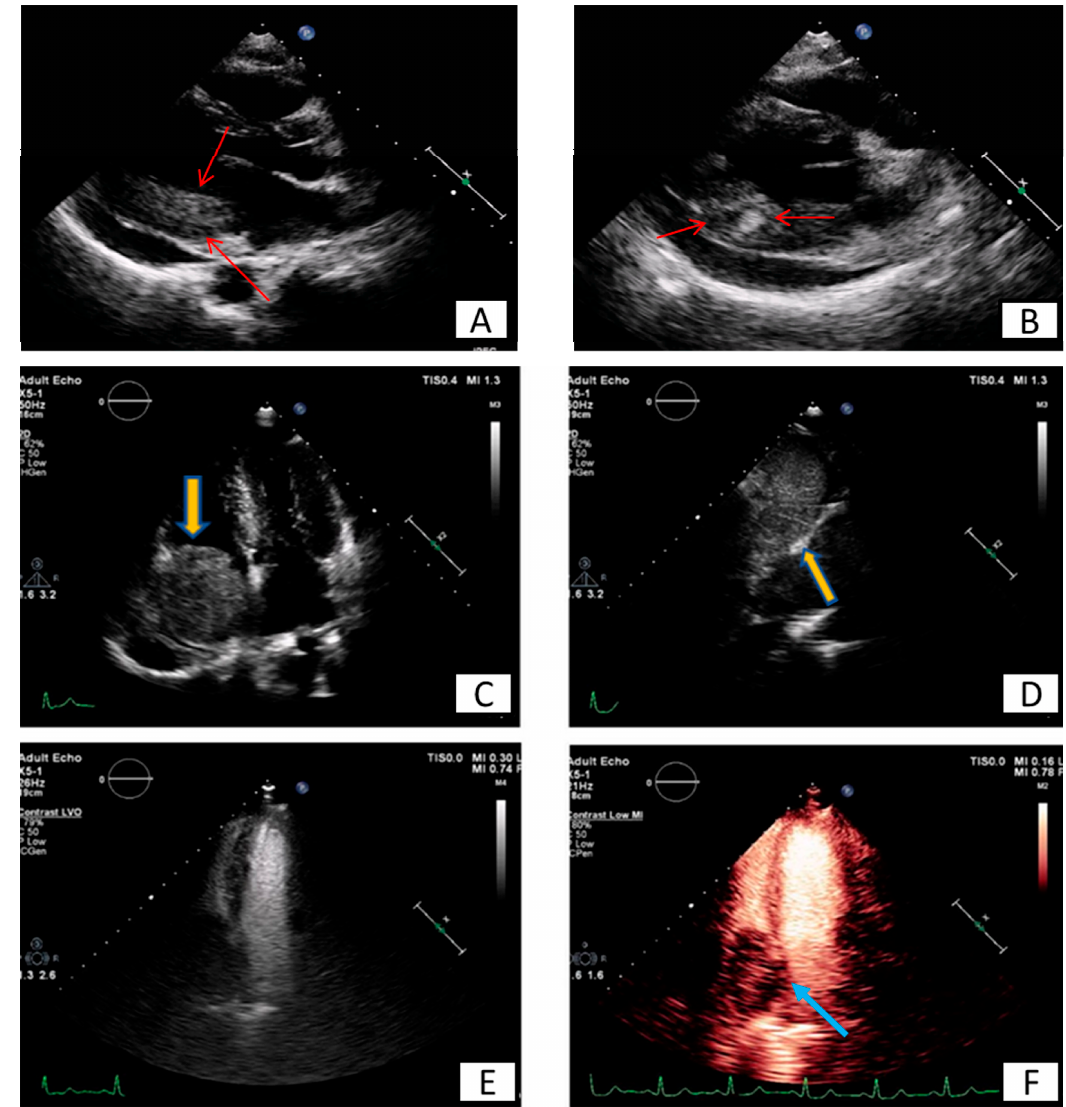
Figure 6. Long ( A ) and modified short axis ( B ) view of transthoracic echocardiography in a young female patient with metastatic carcinoma. Note the presence of pericardial e ff usion and the increased echogenicity and inhomogeneity of the basal posterior myocardial wall finding consistent with malignancy (red arrows). ( C – F ) Patient presenting with dyspnea on exertion and right heart failure symptoms during last months. A large mass (5.2 × 4.8 cm) is depicted inside the right atrium ( C ), originating from inferior vena cava ( D ). Utilizing echo contrast agents, the increased vasculature of the mass is revealed, a finding supportive of malignancy ( E , F